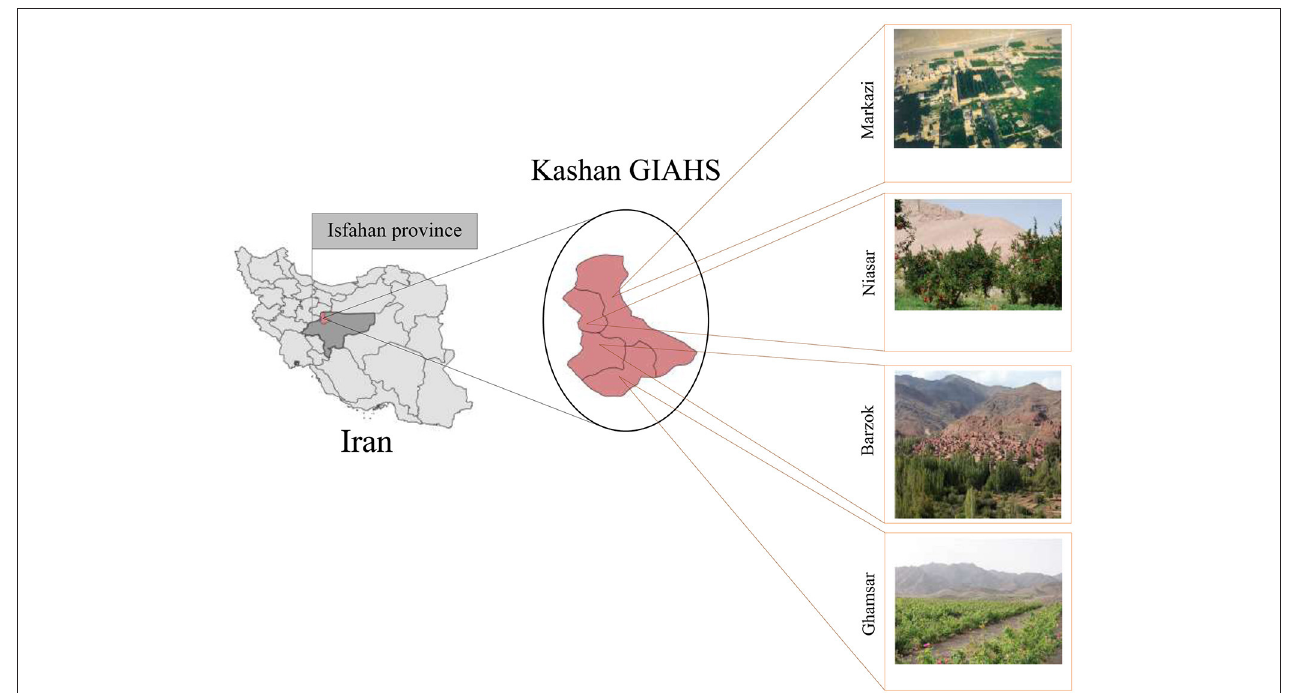
FIGURE 3 | The location of Kashan